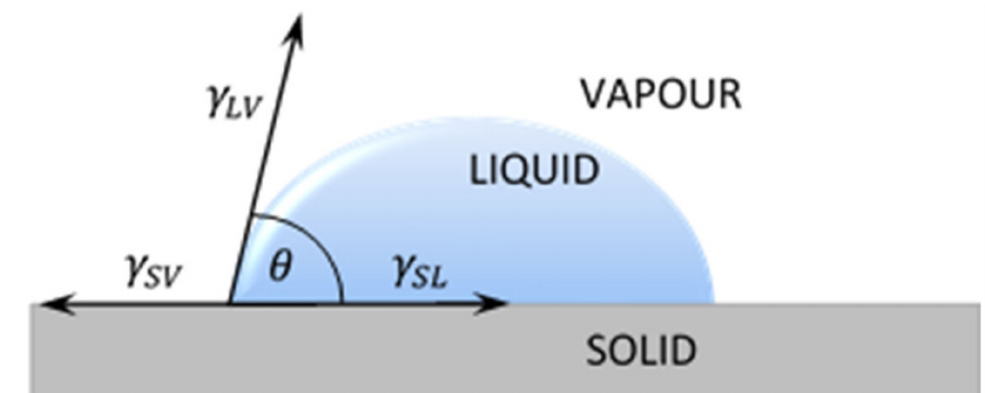
Figure 2. A liquid droplet remaining in equilibrium state with a plane solid surface: γ SL - free surface energy between solid and liquid; γ SV - free surface energy between solid and vapor; γ LV - free surface energy between liquid and